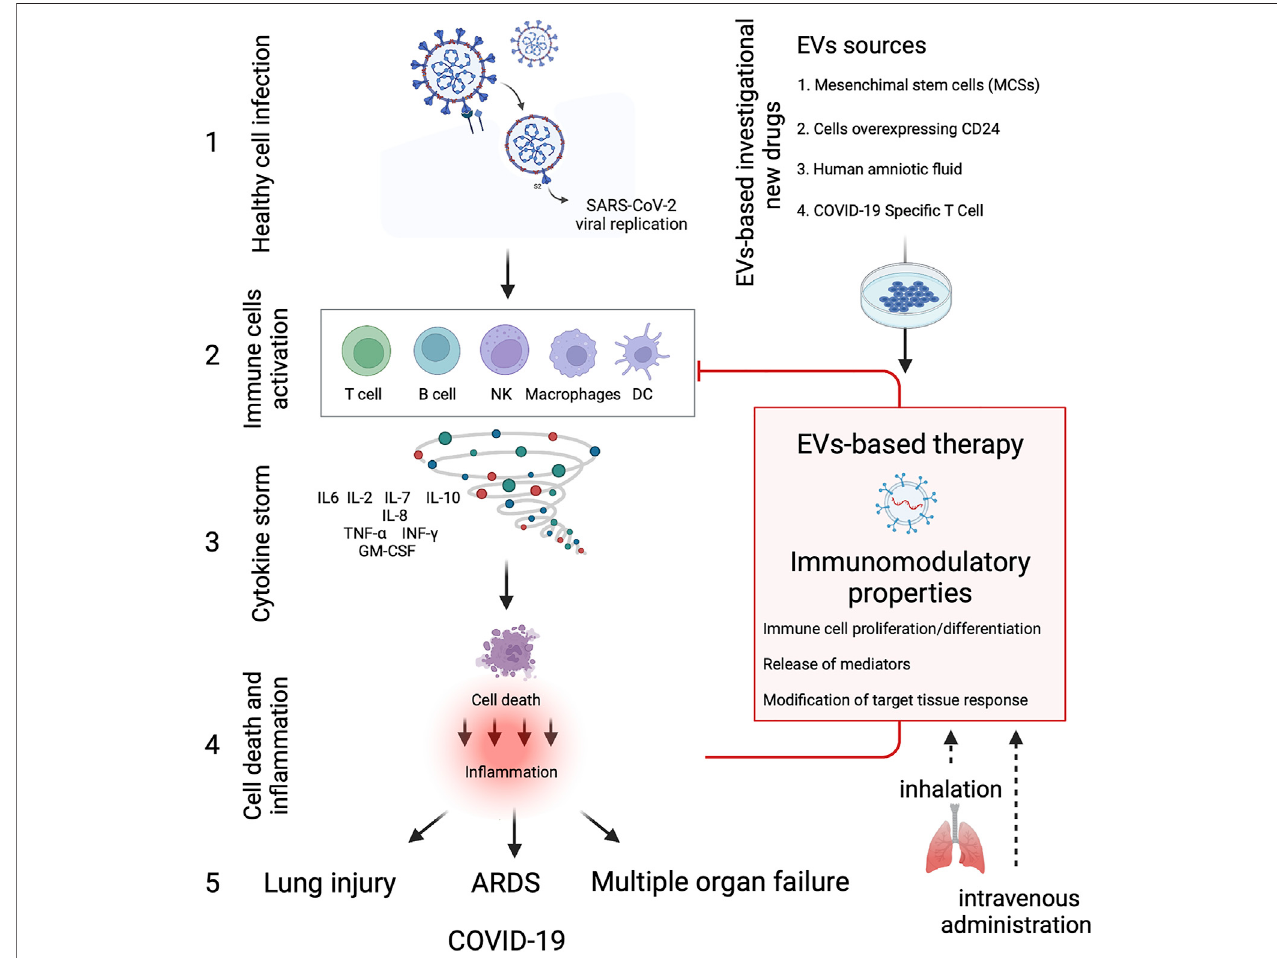
FIGURE2| EVs-basedtherapyinCOVID-19.DiagramshowingtheimmunecellsactivationandcytokinestormproducedduetoSARS-CoV-2infection,leadingto severe in fl ammation and tissue dysfunction. EVs-based investigational new drugs against COVID-19 can be classi fi ed as 1) EVs derived from allogeneic mesenchymal stem cells (MSCs), 2) EVs overexpressing CD24 isolated and puri fi ed from human embryonic kidney T-REx ™ -293 cells engineered to express high levels of human CD24; 3) EVs extract from human amniotic fl uids (Zo fi n) and 4) EVs derived from allogenic COVID-19 T cells. EVs-based therapies possess immunomodulatory properties and can suppress and inhibit innate and adaptive immune cells ’ activation, maturation and proliferation, downregulate cytokine storm, and modify the target tissue response. Besides the conventional intravenous administration, EVs-based therapies can reduce the in fl ammatory response in the lung through inhalation, thus regenerating the damaged alveolar epithelium and endothelium at a lower concentration dose. The Figure was created with Biorender.com.